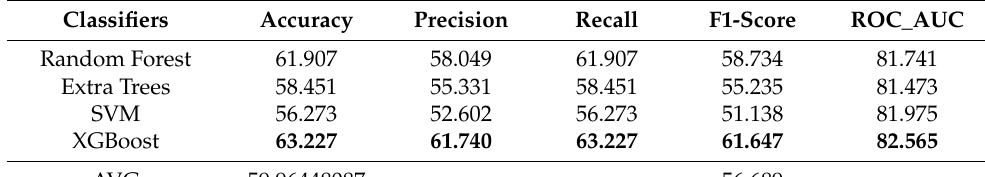
Table 3. CNV Raw Experimental Results.